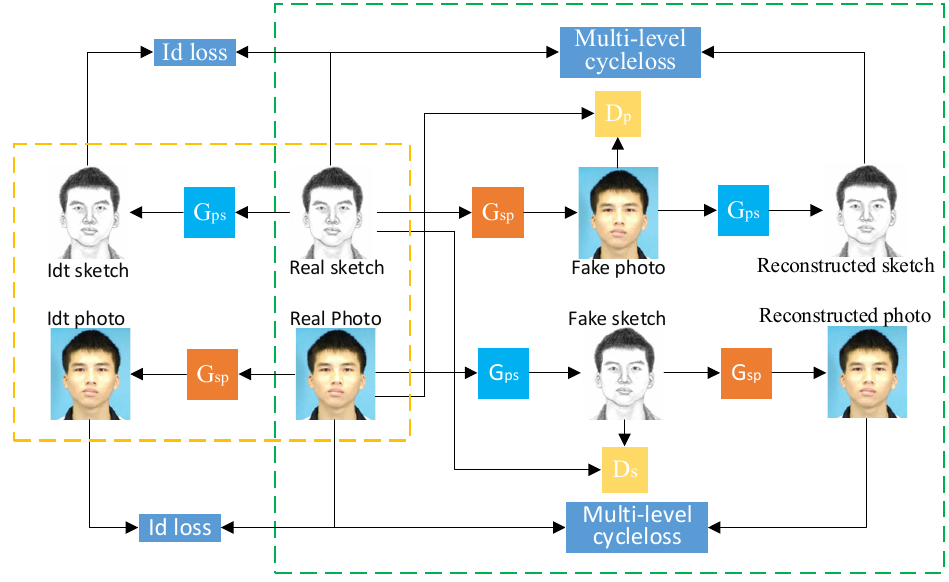
Figure 1. Overall network framework.